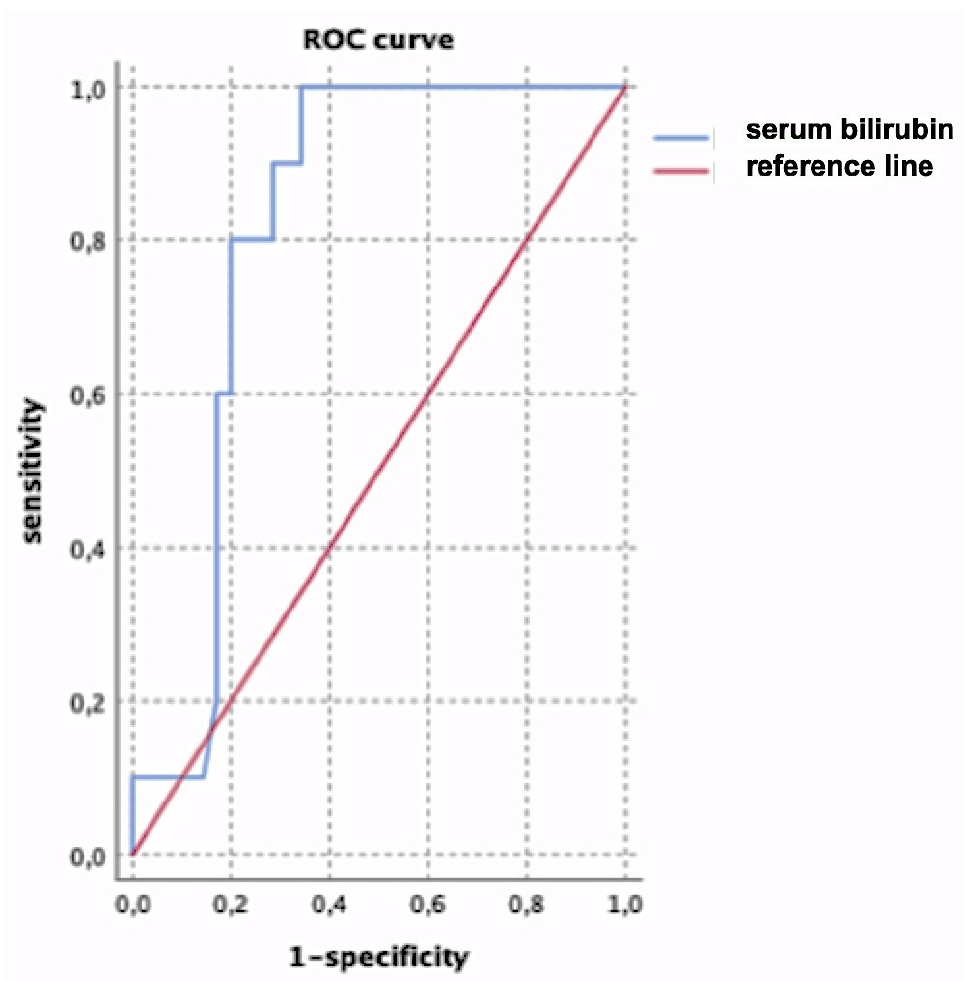
Figure 2. ROC curve analysis of serum bilirubin as a predictor of pulmonary haemorrhage. The best combination of sensitivity (0.8) and 1-specificity (0.2) was identified for a serum bilirubin ≥ 11.5 mg/dL.